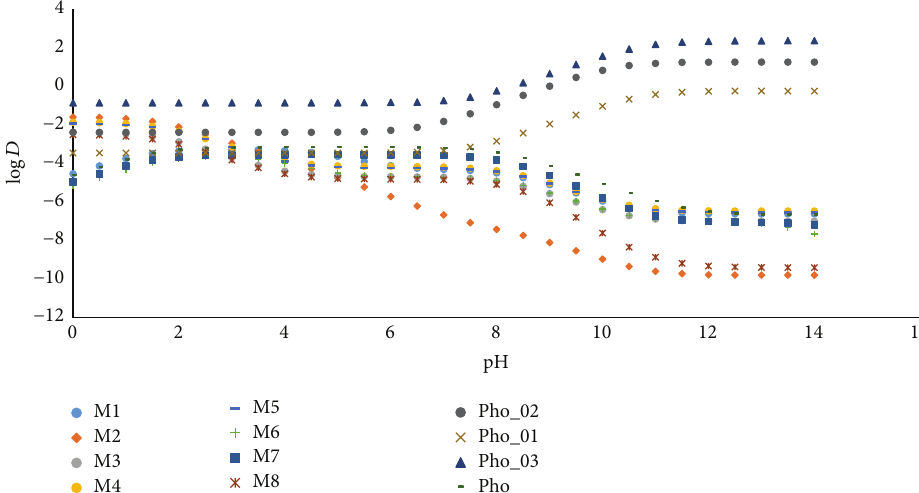
Figure 3: log 𝐷 of phosphoethanolamine (Pho), analogues (Pho 01 to Pho 03), and metabolites (M1 to M8) in different pH values.